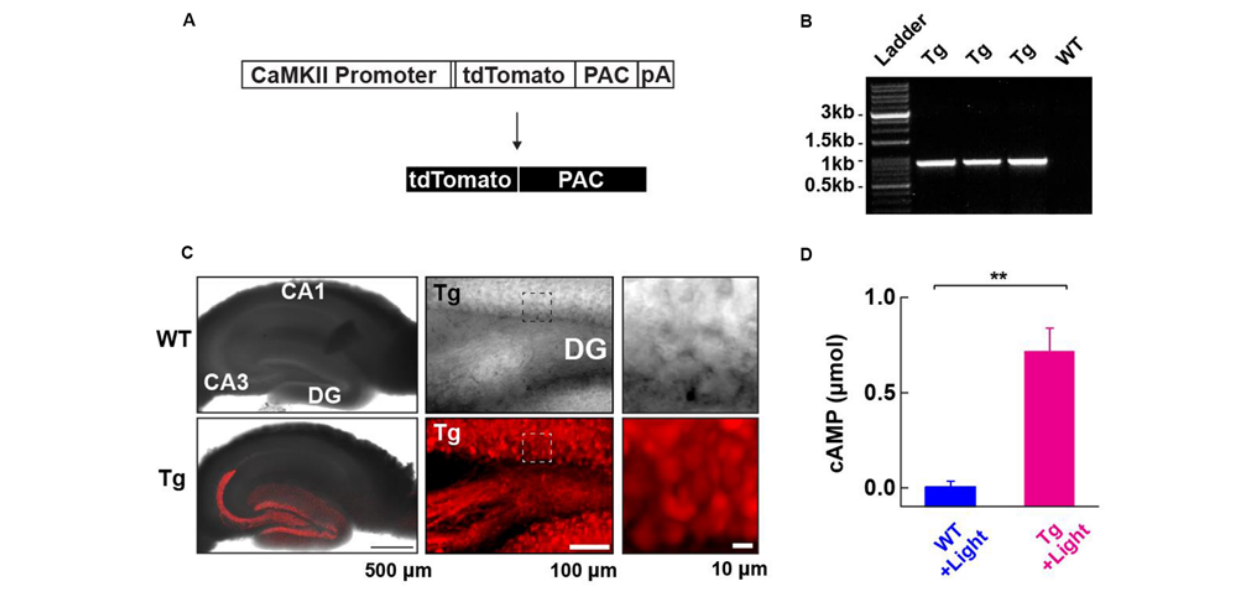
FIGURE 1 | Generation and characterization of photoactivatable adenylyl cyclase (PAC) expressing transgenic (Tg) mice. (A) Schematic representation of the PAC transgene construct. (B) Genotyping of the Tg(CMV-Camk2a-RFP/PAC)3Koka mice. The specific PCR amplification of an 859 bp band for PAC in Tg, but not wild-type (WT) mice was detected on the agarose gel. (C) Distribution of RFP (tdTomato)-PAC in the hippocampal slice. Left upper: WT (wild type), Left lower: Tg (PAC transgenic mouse). The RFP fluorescence (red color) on the living hippocampal slice was imaged by a confocal microscope and merged with the transmitted light image. Note: the red labeling extending into the CA3 region reflects signals in the mossy fiber axons of the DG granule neurons. Middle: a transmitted light (upper) and the corresponding red fluorescence (lower) deconvoluted confocal images of the hippocampal DG area in a living PAC Tg mouse hippocampal slice. About 85% of DG granule cells (141/163 cells) showed red fluorescence signals above the background level. Right: The transmitted light (upper) and the corresponding red fluorescence (lower) images within the boxed region in the middle images. (D) ELISA-based detection of the light-dependent cAMP production in the WT and Tg hippocampal lysate (per mg total protein) after illumination (455 nm LED, 4.5 mW/mm 2 , 30 s; each n = 3). ** p < 0.01 (unpaired t -test). Data are presented as mean ±